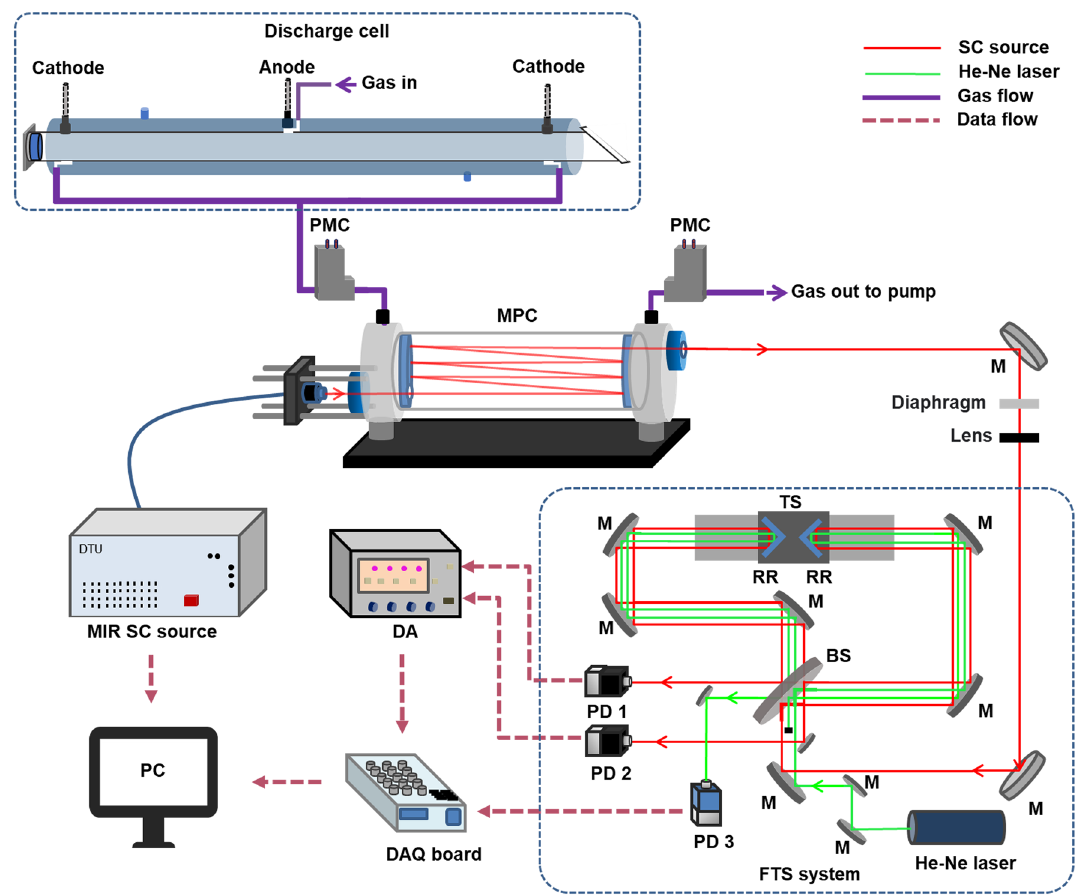
Figure 1. Experimental setup of the SC source and FTS-based multi-species detection system. MPC multipass cell, PMC pressure meter & controller, M mirror, TS translation stage, RR retroreflector mirror, BS beamsplitter, He–Ne laser helium–neon laser, PD photodetector, DA differential amplifier, DAQ board data acquisition board, PC MPC. The light intensity at these specific peaks is reduced in both the background and measurement spectrum to an extent that it degrades the fitting quality. The linear response of the system to different applied CO 2 concentrations was evaluated in a dynamic range between 0.05% and 2.5% of CO 2 in N 2 , by diluting the 5% CO 2 in N 2 mixture further using pure N 2 gas. Each measurement consists of 500 averaged spectra, measured in ~ 16 min. The reference spectra for the linear fitting routine were simulated from the HITRAN database as described before. The retrieved concentrations from the fit versus the applied concentrations are shown in Fig. 4, together with the corresponding errors, exhibited in the lower panel. The linear fit shows a Pearson correlation coefficient square value of 0.9995, demonstrating a very good agreement between the measured concentration values and the applied concentrations. The corresponding relative errors are within a ± 4% margin for the entire range, with an average error of 2%.